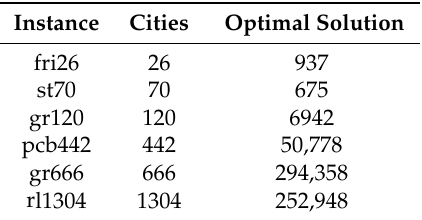
Table 1. Datasets used in